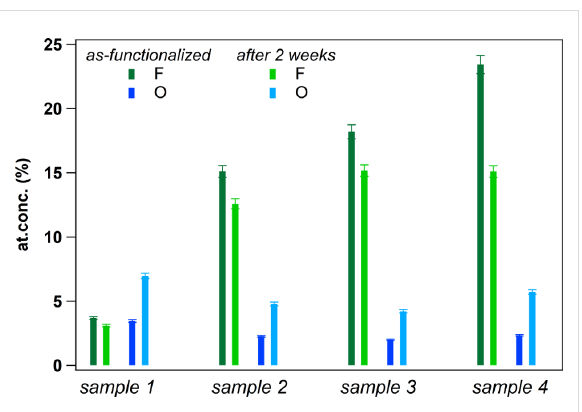
Figure 6: The stability of the fluorination is presented as a function of time for four different samples containing increasing amount of fluo- rine grafted at the surface. Green and blue colours represent the fluo- rine and the oxygen amounts calculated by XPS, respectively. Lighter shades are used to represent the contents after storing the samples two weeks in ambient